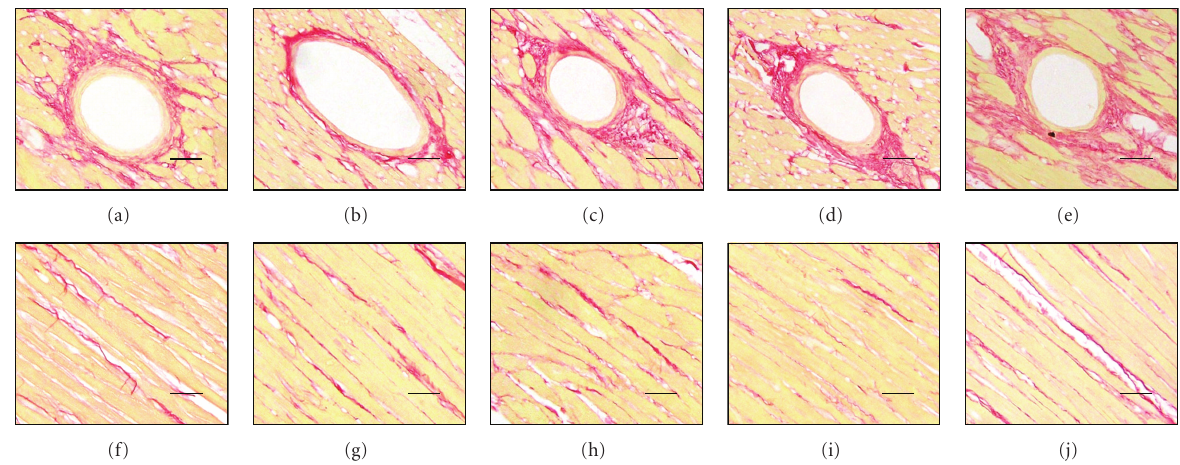
Figure 3: Representative light micrographs of cardiac (a–e) perivascular and (f–j) interstitial fibrosis in senescent SHRs treated with (a, f) vehicle (control), (b, g) candesartan cilexetil (2mg/kg/day), (c, h) candesartan cilexetil in combination with PD123319 (10 mg/kg/day), (d, i) PD123319 alone, or (e, j) hydralazine (30mg/kg/day). Scale bar = 50 µ m.